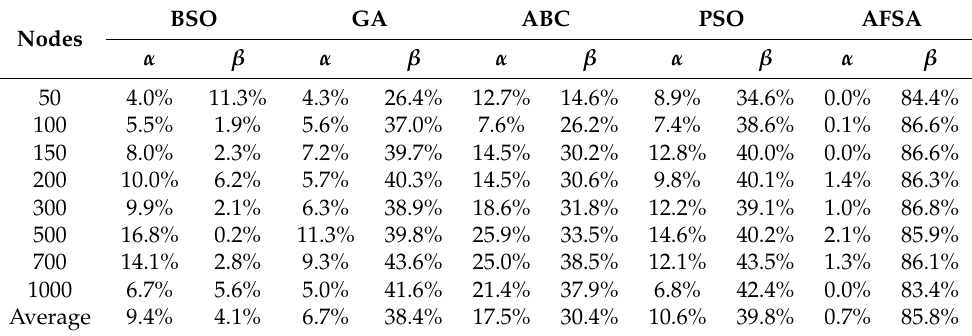
Table 4. Comparisons between the IBSO , BSO and four original heuristics algorithms. Nodes